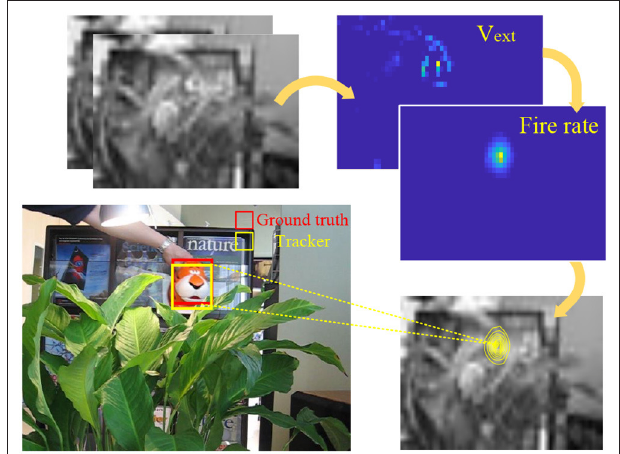
FIGURE 2 | Illustration of CANN-based object